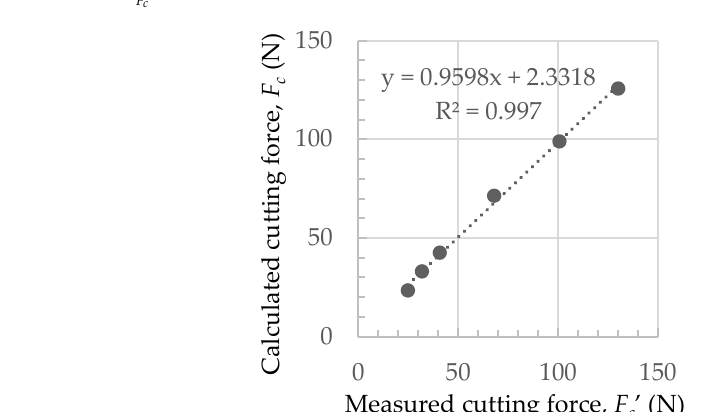
1 The cutting force measured by the smart tool holder; 2 the equivalent cut width calculated by Equation (9); 3 the equivalent cut thickness calculated by Equation (9); 4 the specific cutting force calculated by F c ’/( b eq ∙ h eq ); 5 the cutting force calculated by Equation (18); 6 |Forced deviation|% = (cid:3007) (cid:3278)